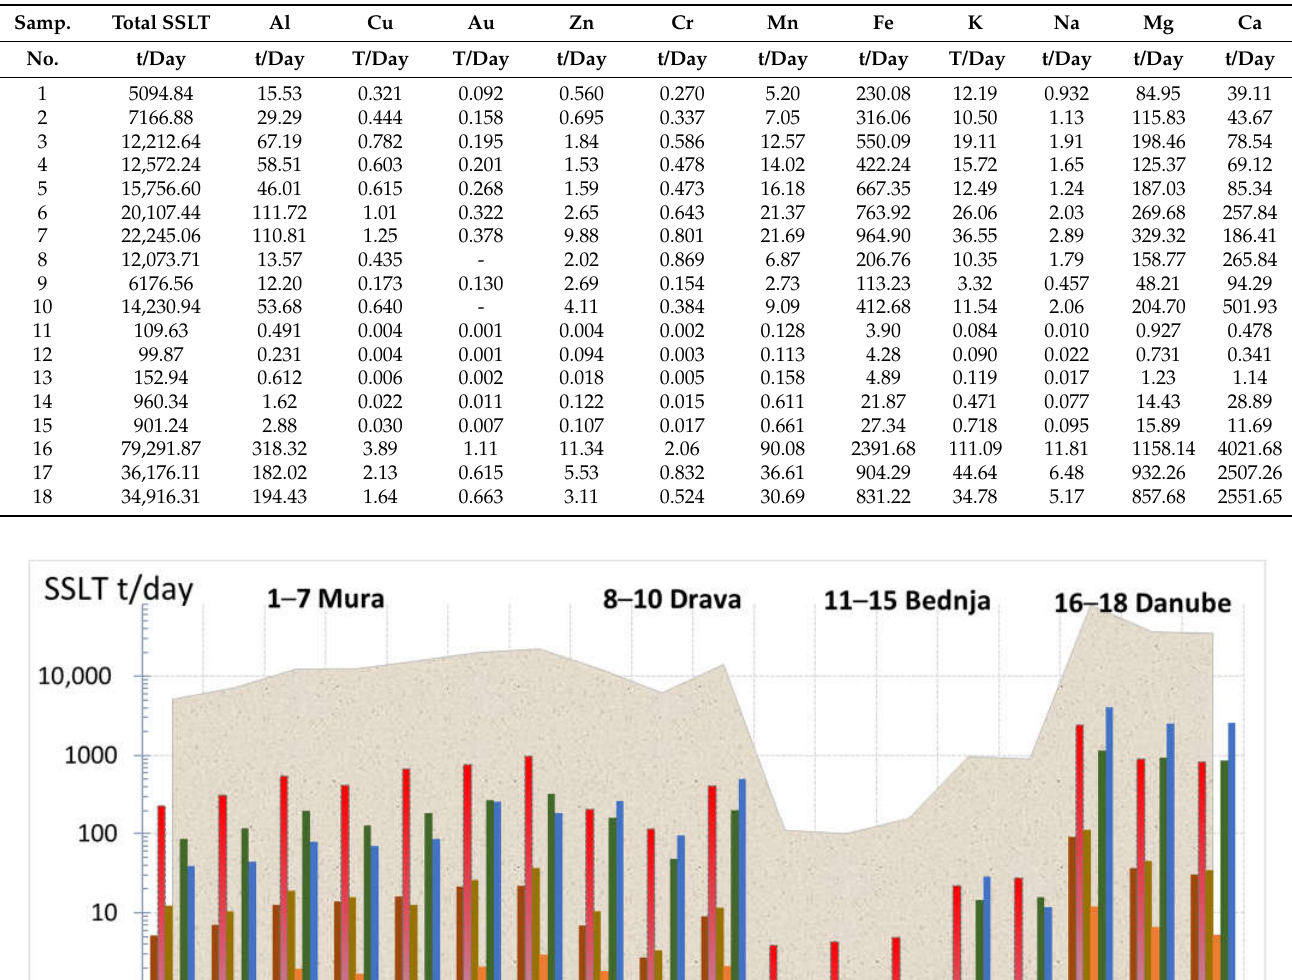
Table 3. The total amount of metals (t/day) in SSLT.